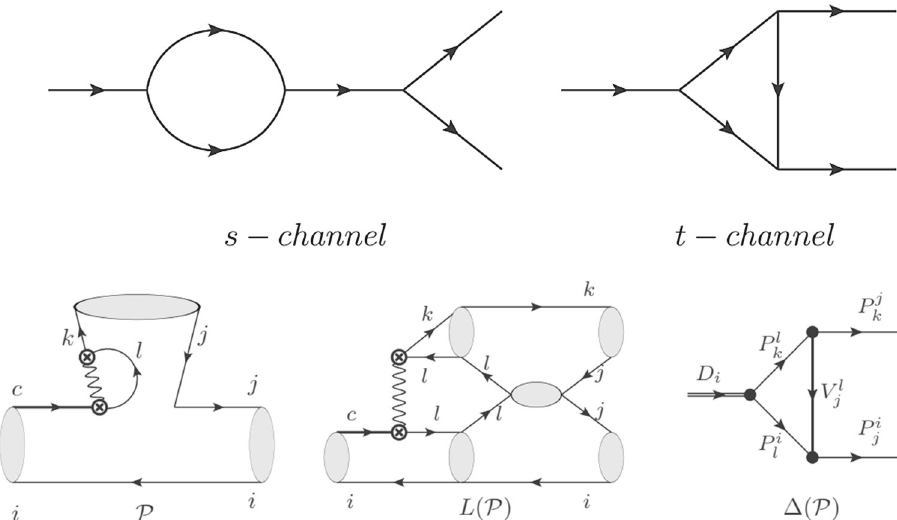
Fig. 4 Final-state interaction effects: s -channel (resonance) and t -channel (rescattering) contributions to one particle exchange